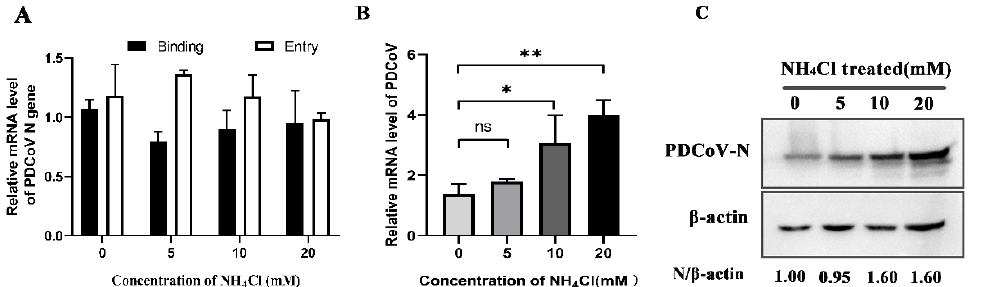
Figure 6. PDCoV enters PK-15 cells in a low-pH-independent manner. ( A ) PK-15 cells were pre- treated with ammonium chloride (NH 4 Cl) at 37 °C for 1 h and infected with PDCoV (MOI of 5) at 4 °C for 1 h (binding step), and then shifted to 37 °C for 1 h (entry step). Cells were lysed to determine viral mRNA level by RT-qPCR. Cells were mock-treated or treated with NH 4 Cl for 1 h followed by infection with PDCoV (MOI = 0.1). At 24 hpi, mRNA expression levels of total PDCoV were detected by real-time quantitative PCR ( B ), and protein expression levels of intracellular PDCoV were de- tected by Western blotting ( C ). * p < 0.05, ** p < 0.01, ns: no significant difference.